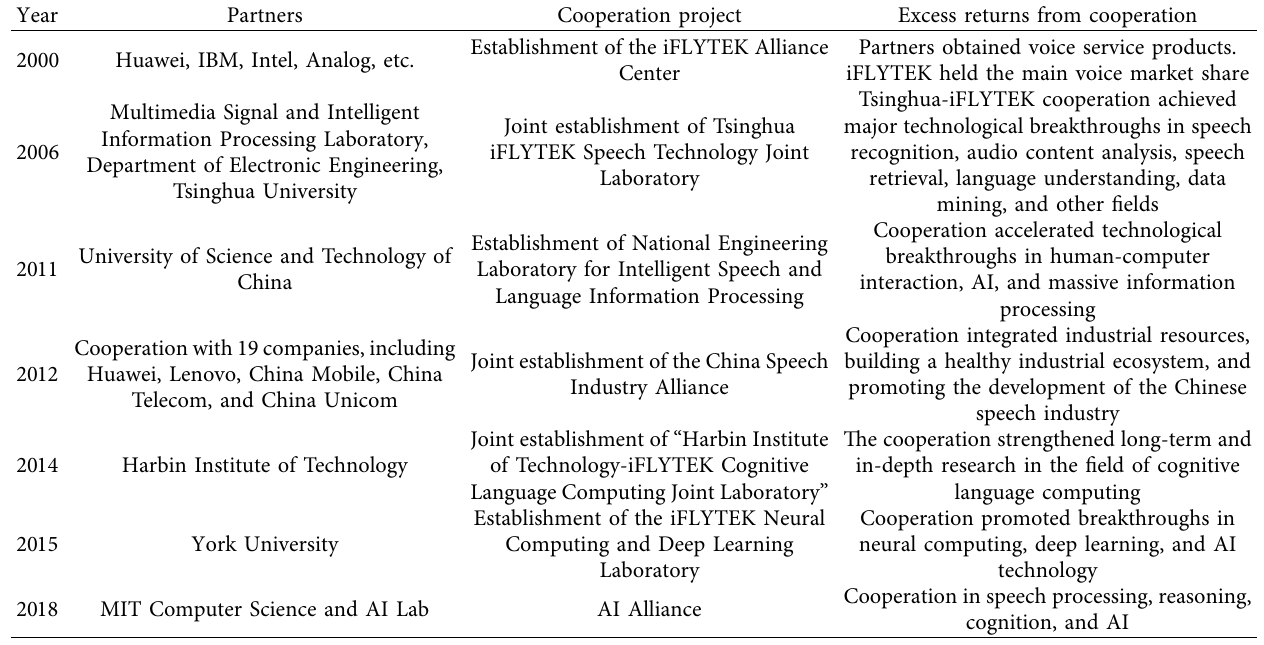
Table 3: iFLYTEK’s cooperation